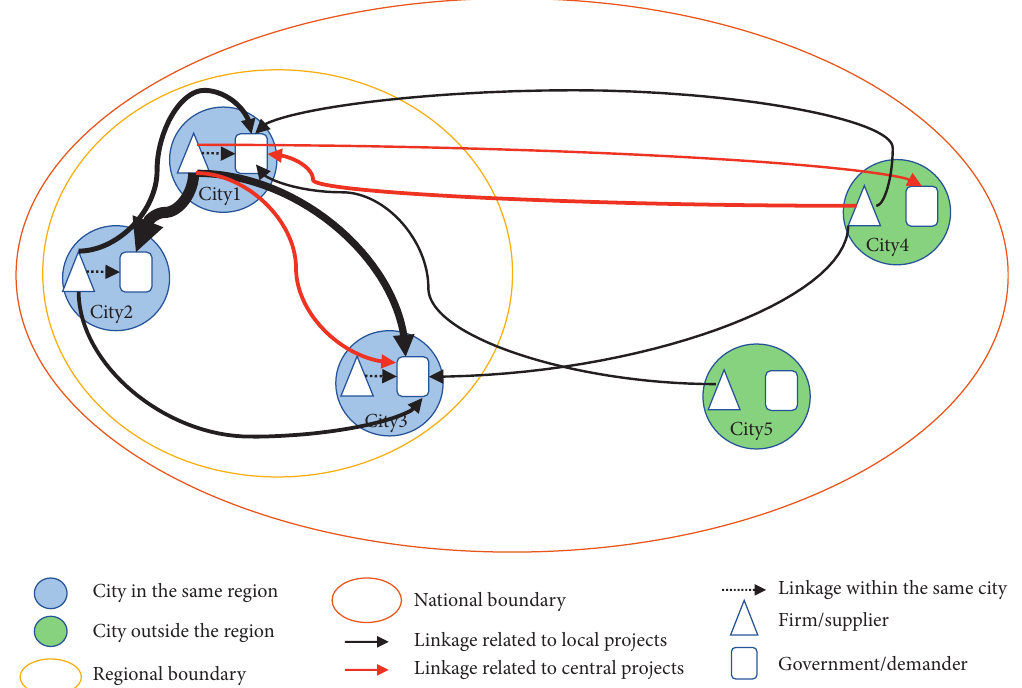
Figure 2: Schematic government procurement activity (GPA) connections.